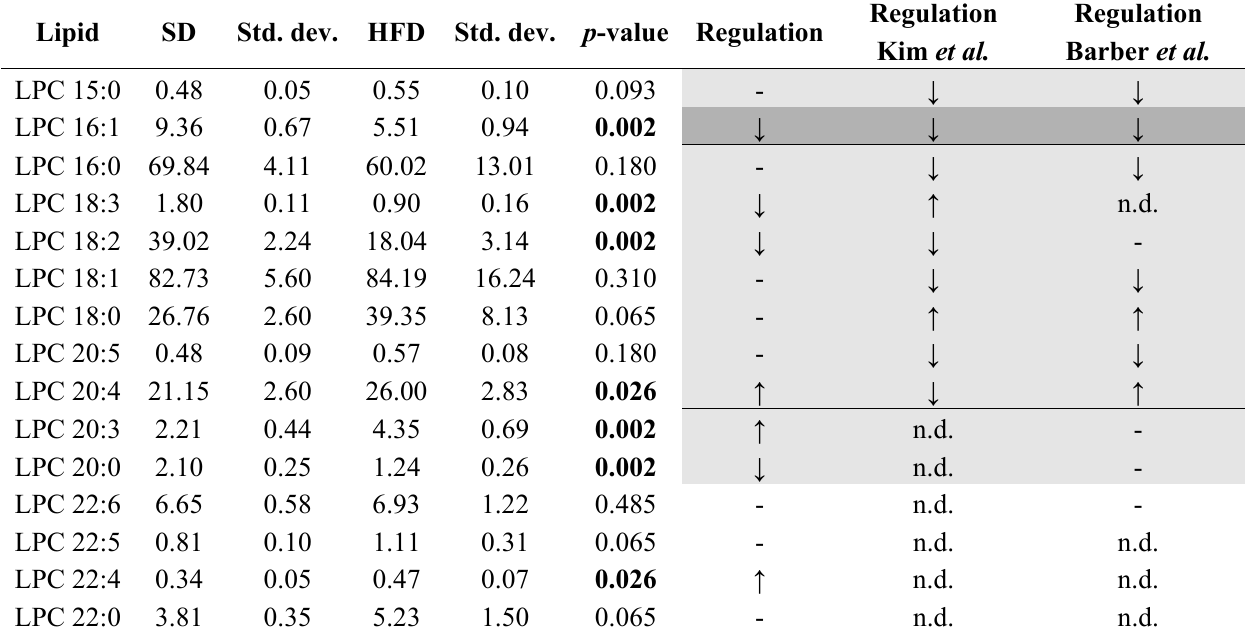
n.d. n.d. The mean values (in µM) ± standard deviation (Std. dev.) are listed. Regulation indicates increased ( ↑ )/decreased ( ↓ )/unchanged (-) levels in serum of HFD fed mice compared to SD fed animals. Significant p -values are shown in bold letters. Regulation described by Kim et al. [11] and Barber et al. [10] is shown for comparison. Lipid species consistently regulated in the three studies are highlighted in dark grey. Differentially regulated lipid species measured in at least two studies are highlighted with light grey. (Not determined,